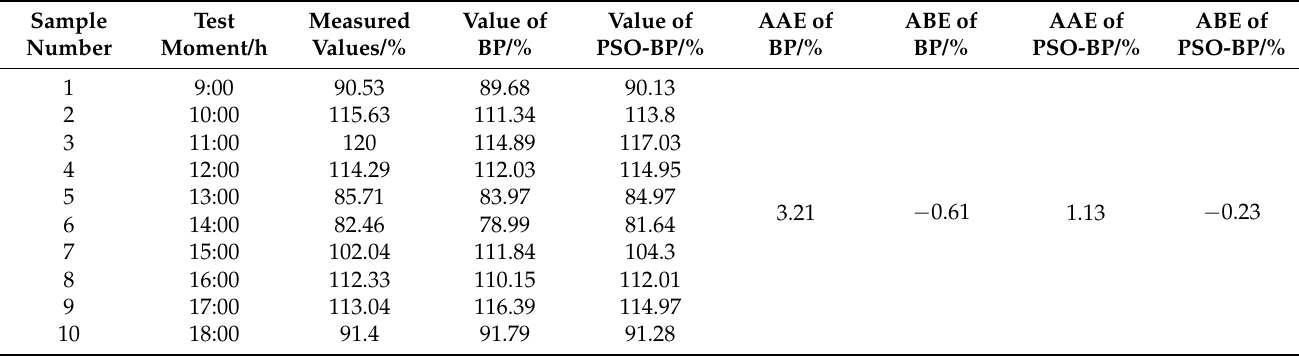
Table 5. Comparison between the BP ANN and the optimized PSO-BP